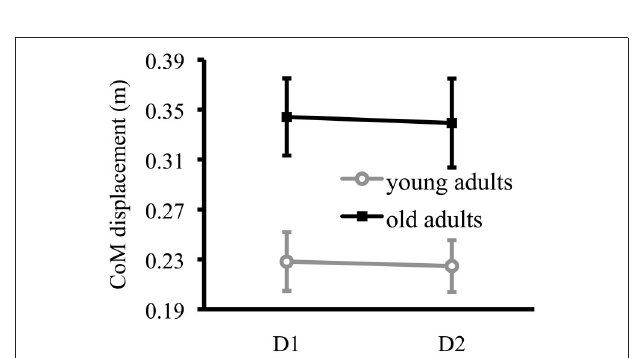
FIGURE 2 | Lateral compensatory stepping performance. Center of mass displacement (CoM) in the lateral direction for healthy young and healthy older adults during lateral compensatory stepping at baseline (D1) and retention (D2). Values are represented as group mean with SE.